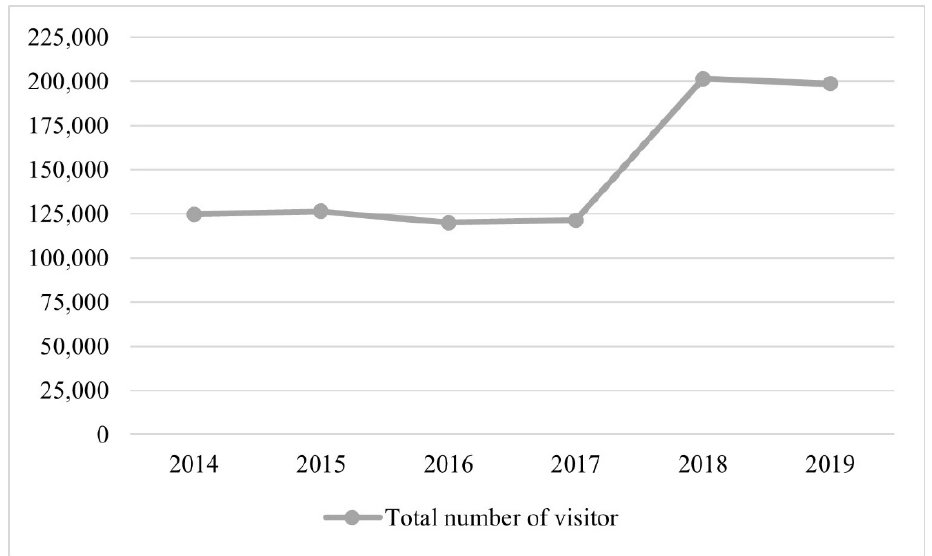
Figure 2. Evolution of the number of visitors of the Benedictine Abbey Church and Museum in Tihany between 2014 and 2019. Source: Own compilation.